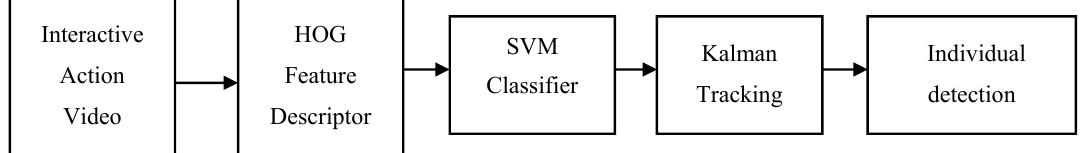
Figure 2. Block diagram of the individual detection algorithm for interactive video.